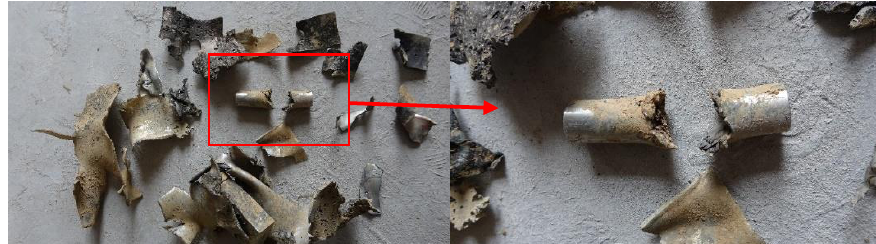
Figure 13. Simulated cabin residual.